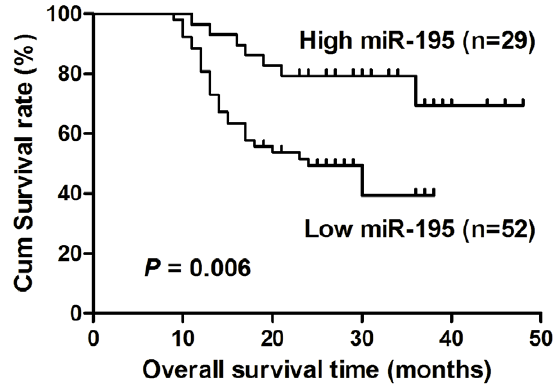
Figure 2. Decreased expression of miR-195 was correlated with poor survival in TSCC patients. Kaplan-Meier curves with log rank tests show that patients with high miR-195 expression (T/N fold change . 0.652) survived statistically significantly longer ( P =0.006) than those with low miR-195 expression (T/N fold change , 0.652). The median miR-195 expression level (T/N=0.652) in the tumor samples was chosen